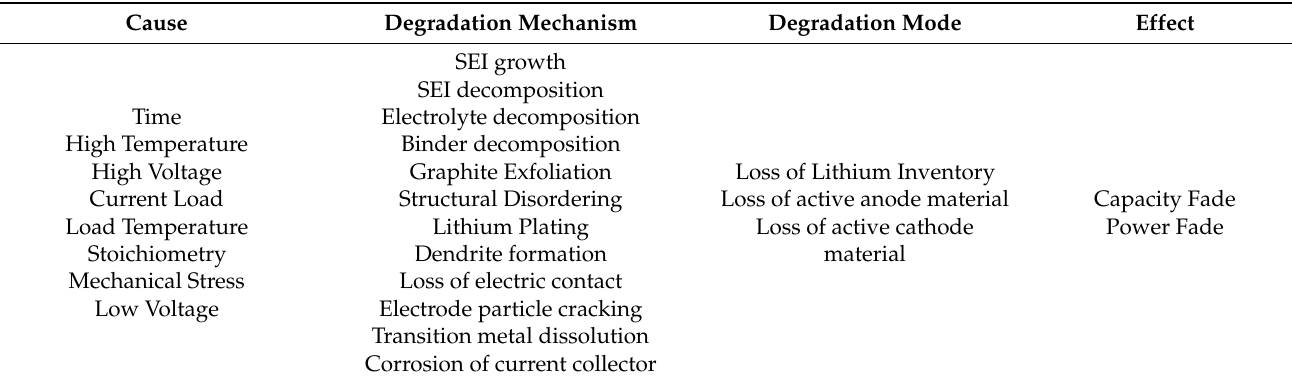
Table 1. Lithium-ion batteries ageing